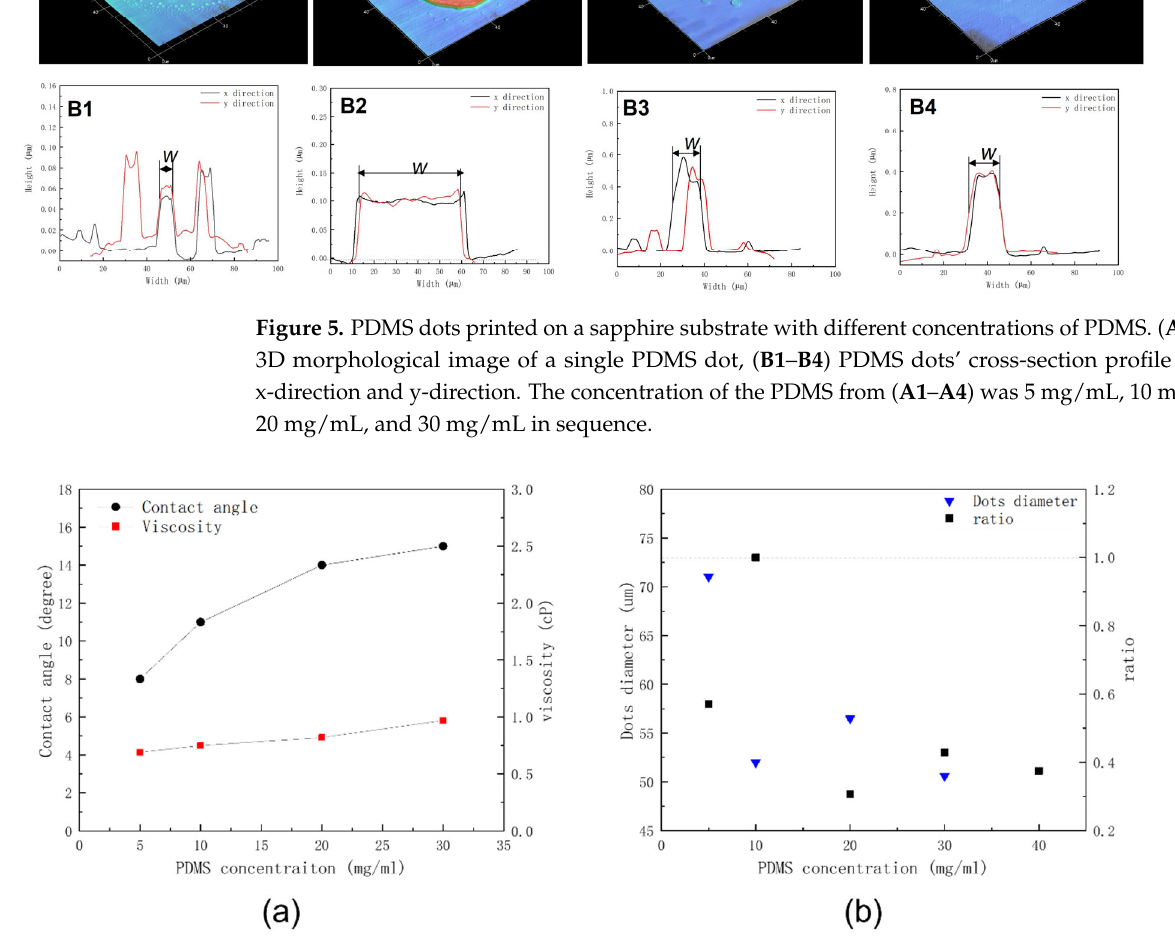
Figure 6. ( a ) Ink viscosity and ink contact angle with different PDMS concentrations at room tem ‐ perature (25 °C), ( b ) PDMS dots’ diameter and ratio of PDMS width to PDMS diameter with differ ‐ ent PDMS concentrations.